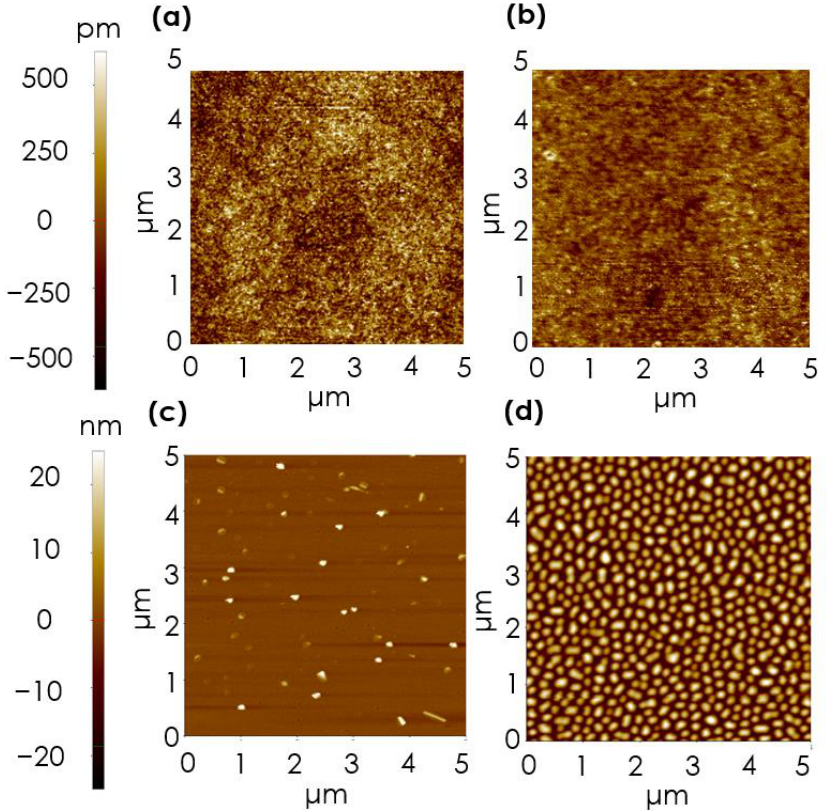
Figure 2. AFM image of ( a ) 750 °C, ( b ) 800 °C, ( c ) 900 °C, and ( d ) 1000 °C annealed samples.